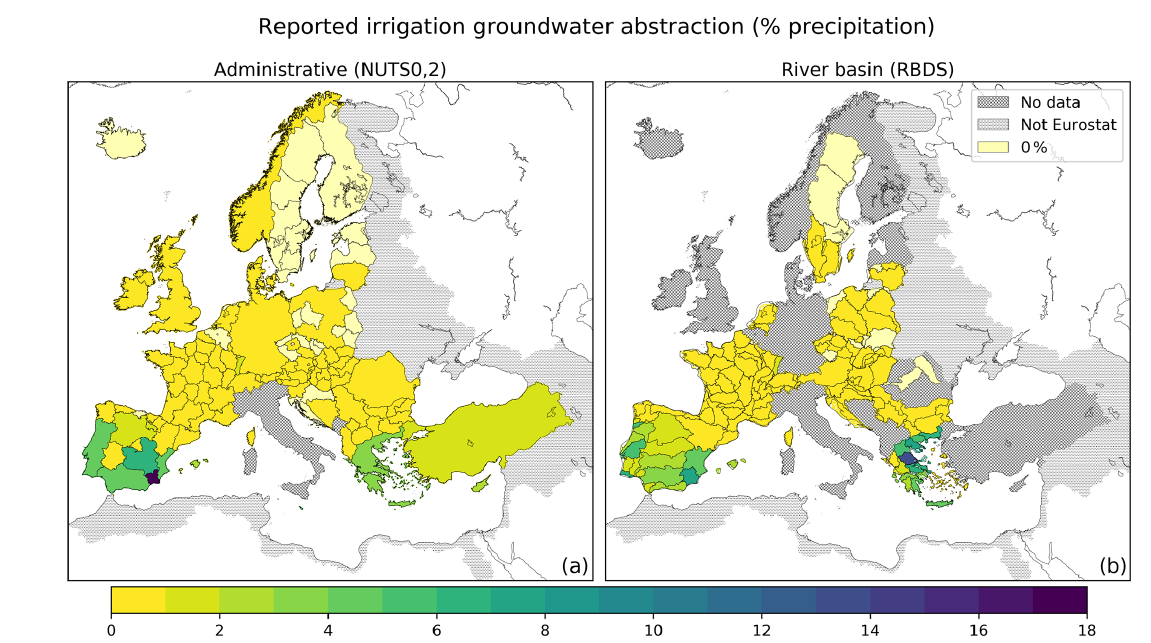
Figure 2. Reported groundwater abstraction for irrigation as percentage of observed precipitation averaged over (a) administrative units (NUTS0, NUTS2), and over (b) WFD river basin districts and sub-basins (RBDs). Where available, NUTS2 and sub-basin figures overlay those reported at NUTS0 and basin levels. Country-wide RBDs are defined for Cyprus, Malta, Albania, Iceland, Kosovo, North Macedonia and Turkey, for which data are mapped only at NUTS0 level. White land areas are outside the Euro-Mediterranean model domain (Fig.